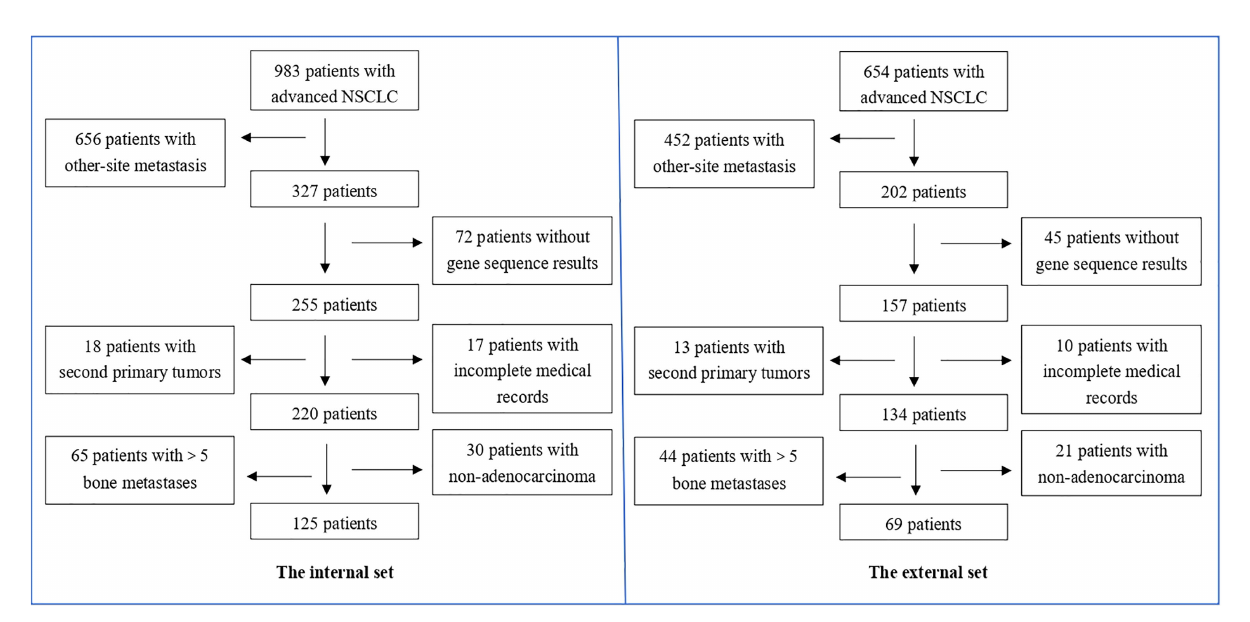
FIGURE 1 | Patient selecting process for the internal set and the external